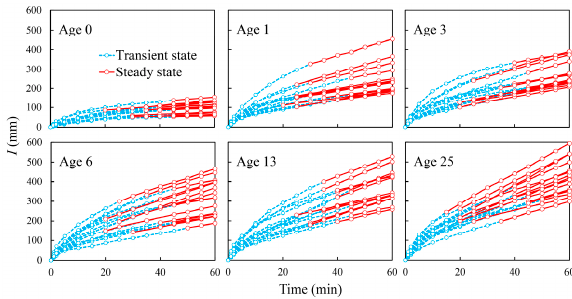
Figure 2. Cumulative infiltration, I (mm), vs. time (min) at the six investigated sites. Blue lines and red lines show, respectively, the transient and the steady-state conditions of infiltration process.